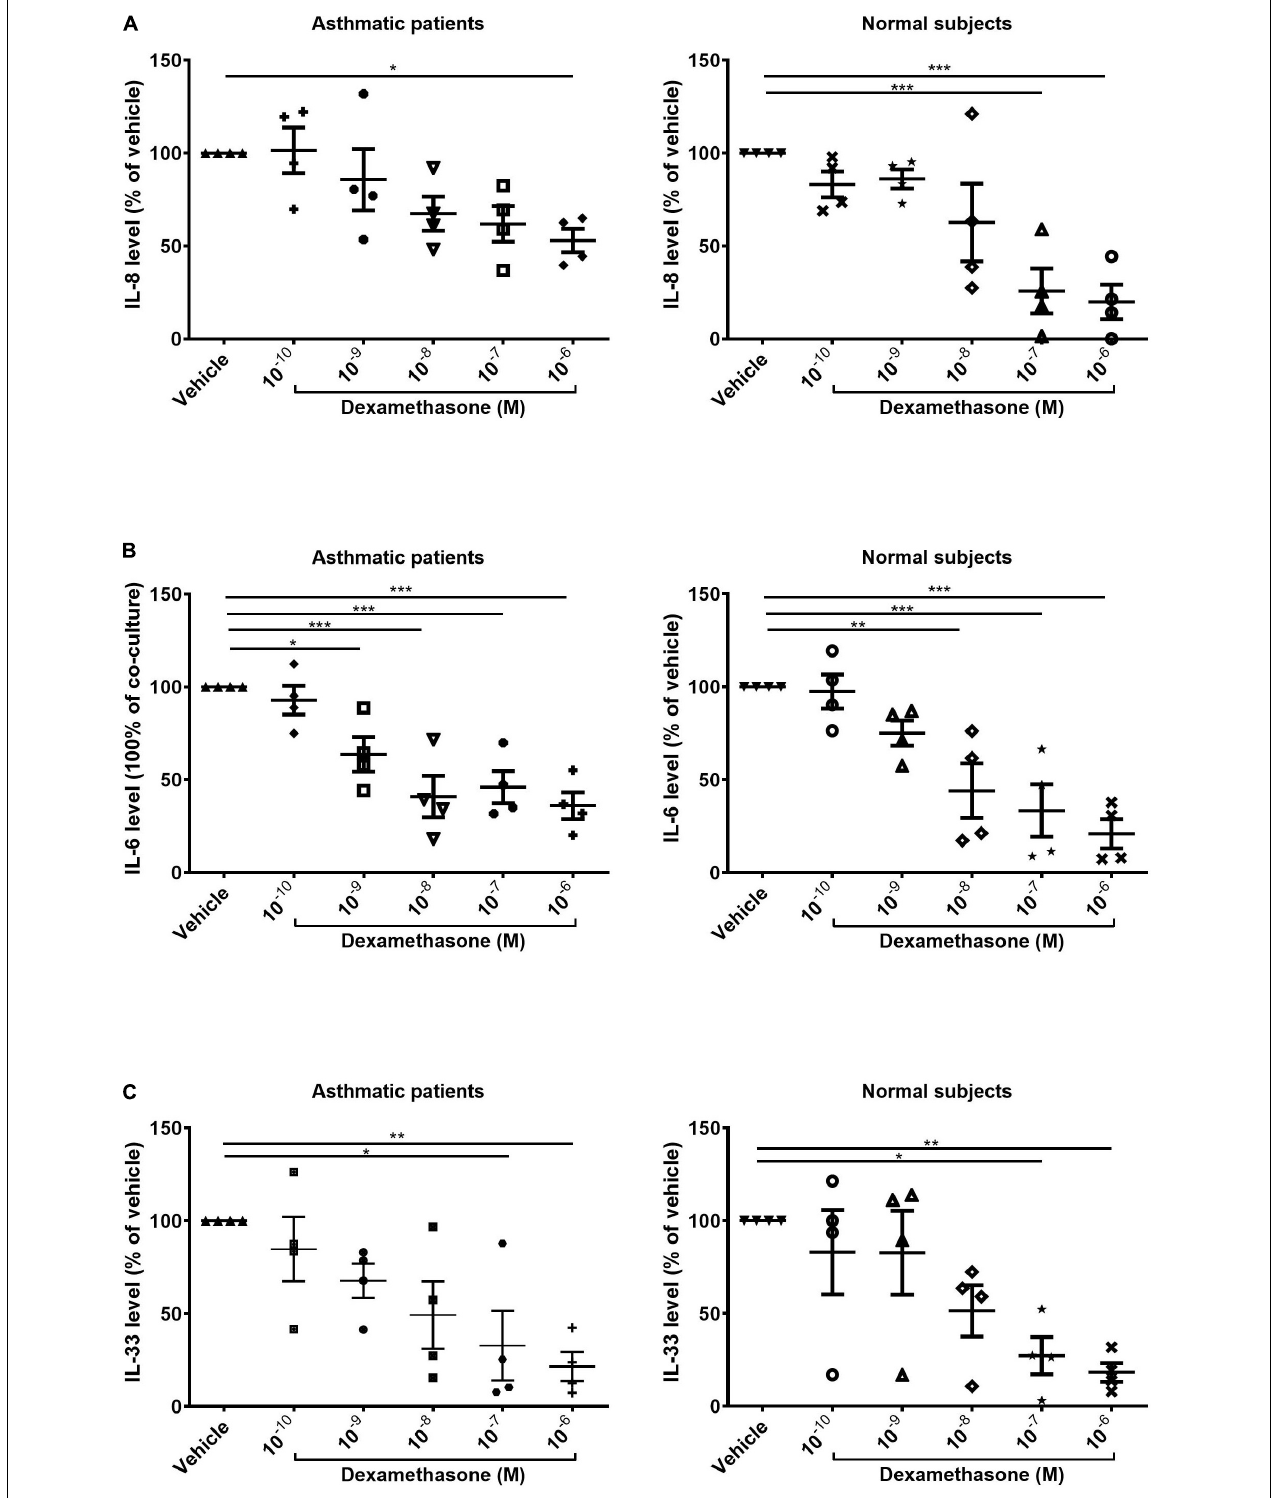
FIGURE 3 | Dexamethasone-induced suppression of (A) IL-8 and (B) IL-6 in the supernatant and (C) suppression of IL-33 in the cell lysates of ASMCs co-cultured with fibrocytes from asthmatic patients and normal subjects (10 − 10 to 10 − 6 mol/L, 48 h). Vehicle: DMSO of same concentration in dexamethasone solution ( n = 4). * P < 0.05; ** P < 0.01; *** P < 0.001.